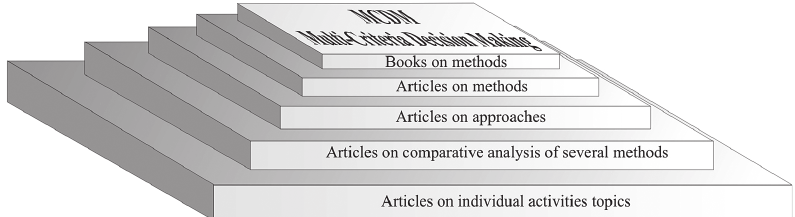
Fig. 3. Five-step pyramid of MCDM